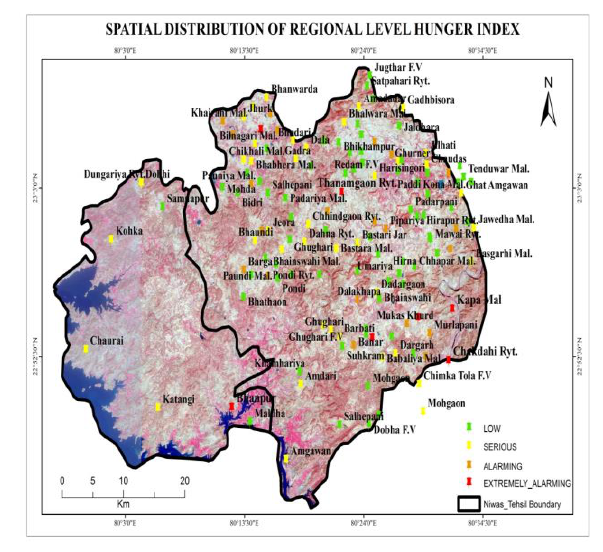
Figure 14. Webmarker display and adding geopoint